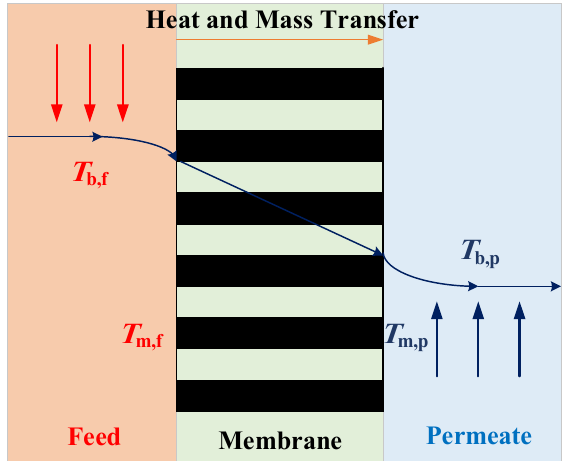
Figure 1. Heat and mass transfer through the membrane in the DCMD configuration.